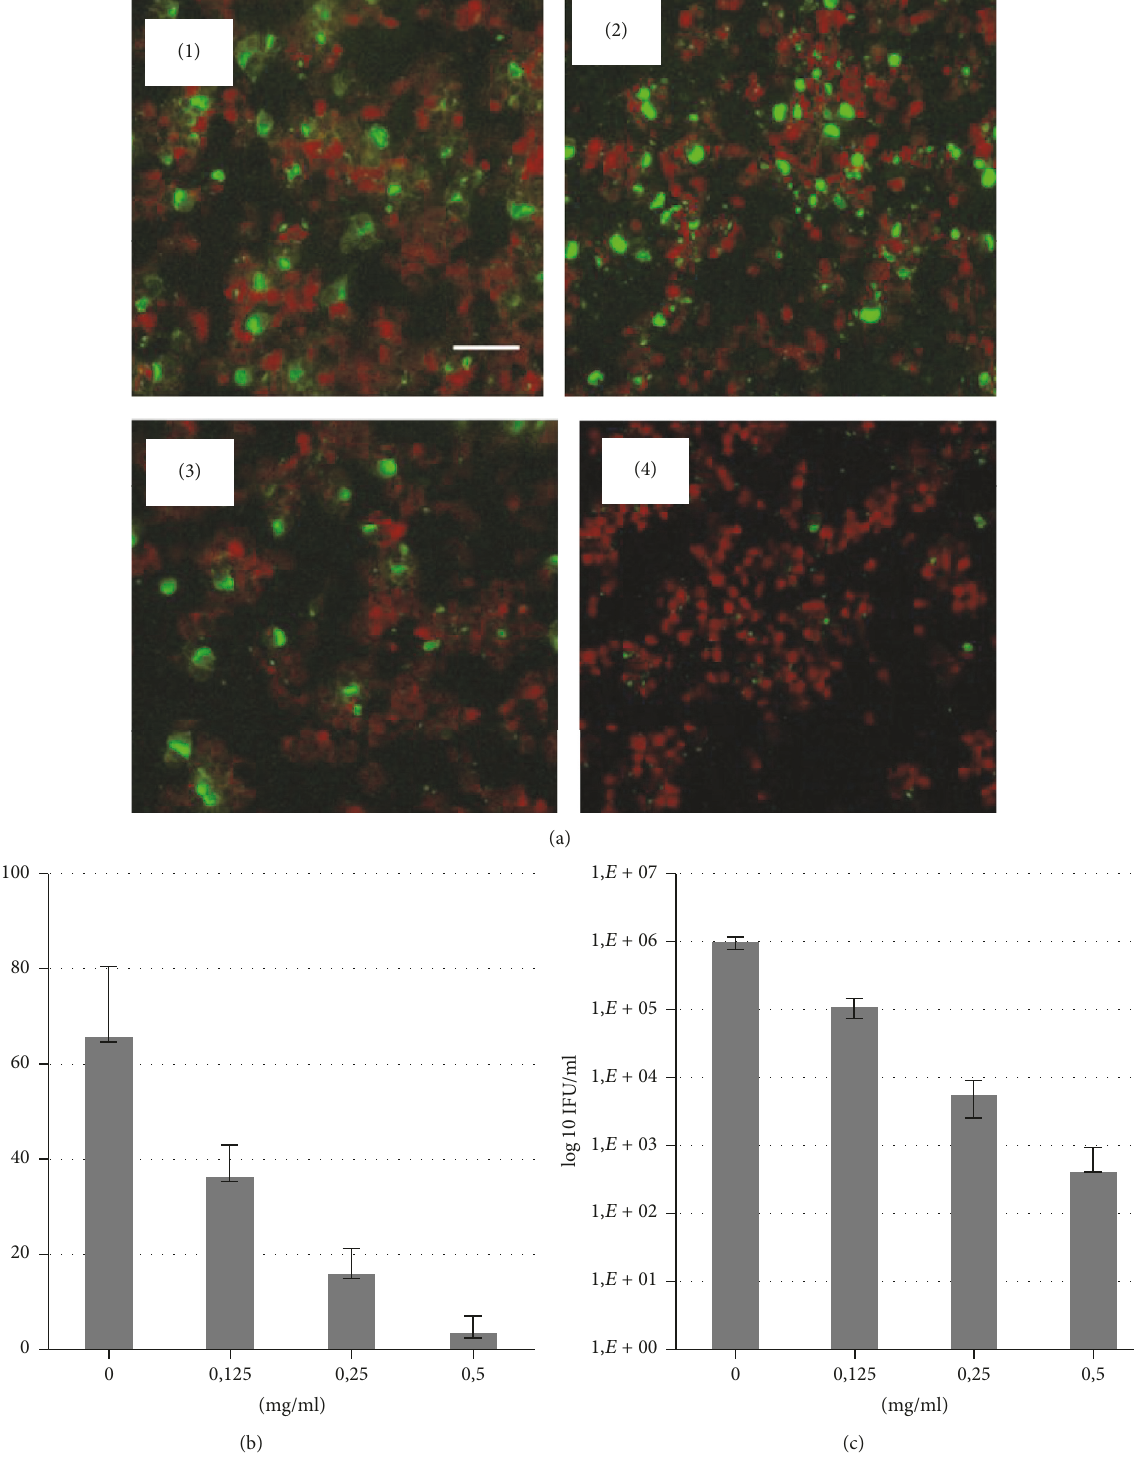
Figure 4: Dose-dependent inhibition of C. trachomatis growth in B10.MLM cells at 42 hpi in the presence of microencapsulated lycopene. (a) C.trachomatis infectioninB10.MLMcellsat42 h.p.i.(1)growthinthepresenceof1.0%cyclodextrin;(2)growthinthepresenceof0.125 mg/ml; (3) 0.25 mg/ml; and (4) 0.5mg/ml of microencapsulated lycopene. Scale bar 100 𝜇 m. (b) Quantitative representation of the inclusion numbers of control and lycopene treated cells. IFU/FOV = Average Inclusion Forming Units per Field of View ( n = 20). (c) Infectious yield after treatment with different doses of